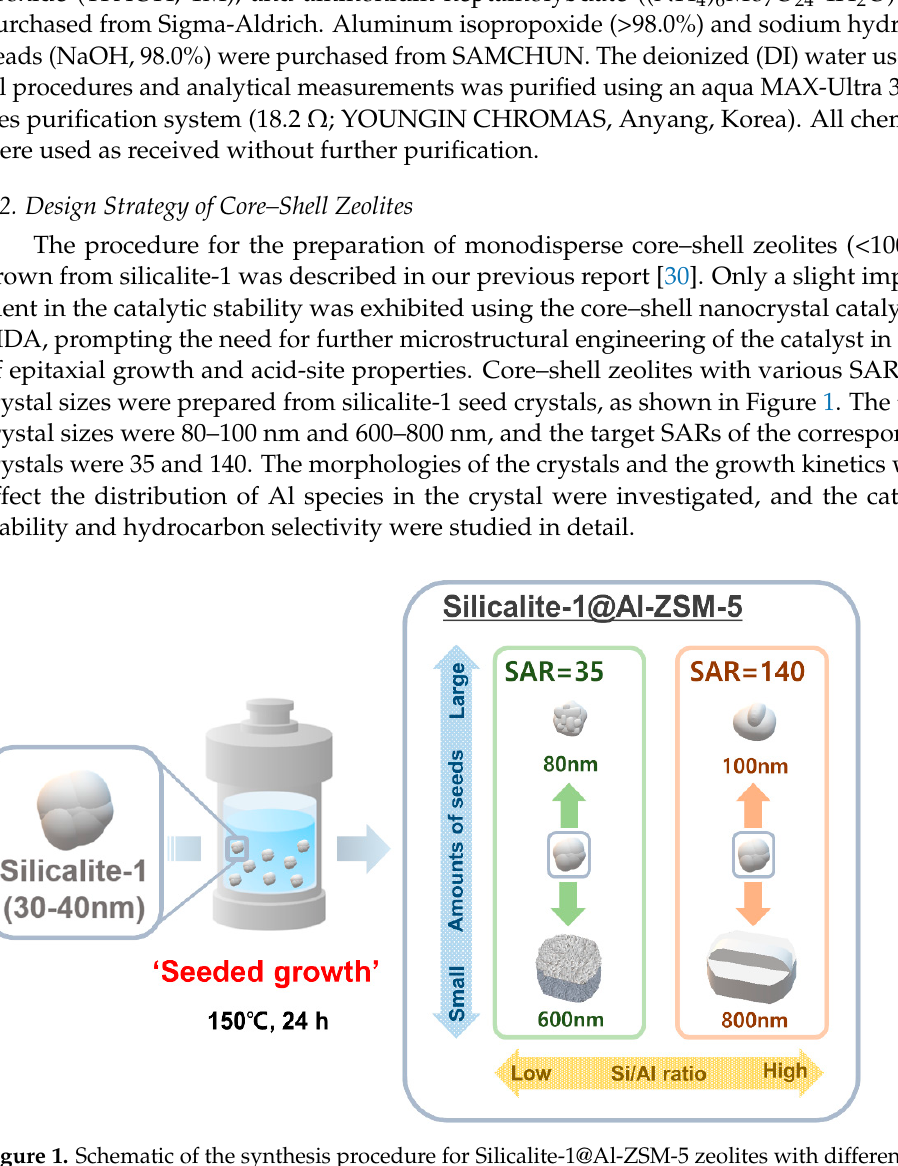
Figure 1. Schematic of the synthesis procedure for Silicalite-1@Al-ZSM-5 zeolites with different sizes and SARs. and